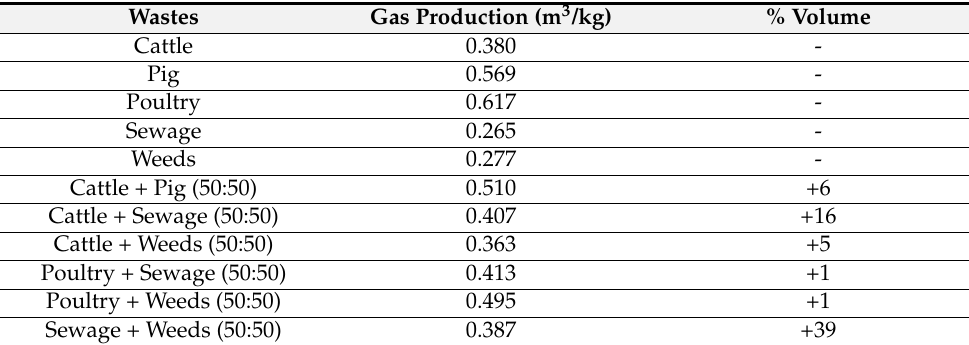
Table 9. Gas yield increase with mixed waste (40-day retention time). Data taken from